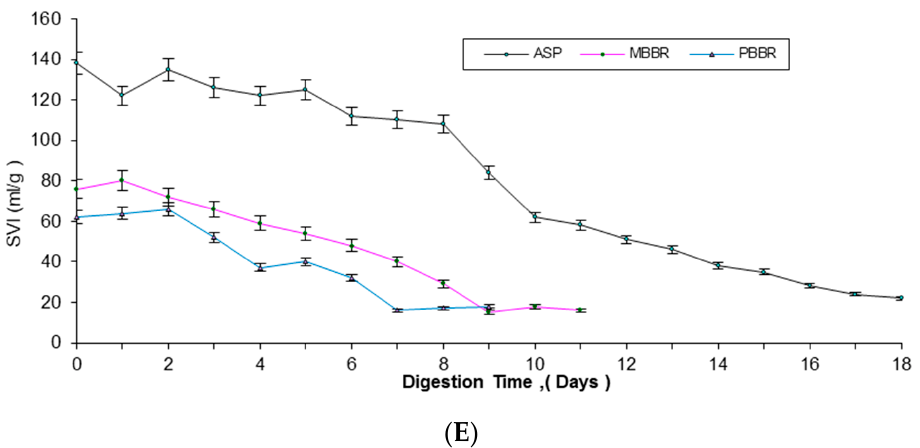
Figure 2. Variation in * MLSS ( A ), MLVSS ( B ), COD ( C ), and DO ( D ) SVI ( E ) during batch aerobic digestion. * legend MLSS: Mixed Liquor Suspended Solid; MLVSS: Mixed Liquor Suspended Solid; COD: Chemical Oxygen Demand; DO: Dissolved Solid; SVI: Sludge Volume Index.